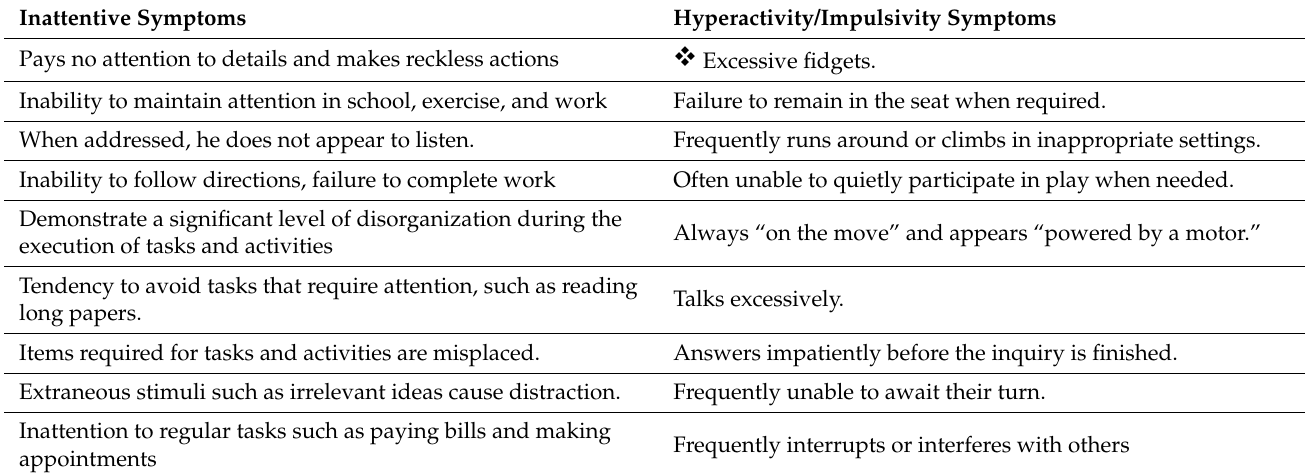
Table 1. Key symptoms of ADHD.